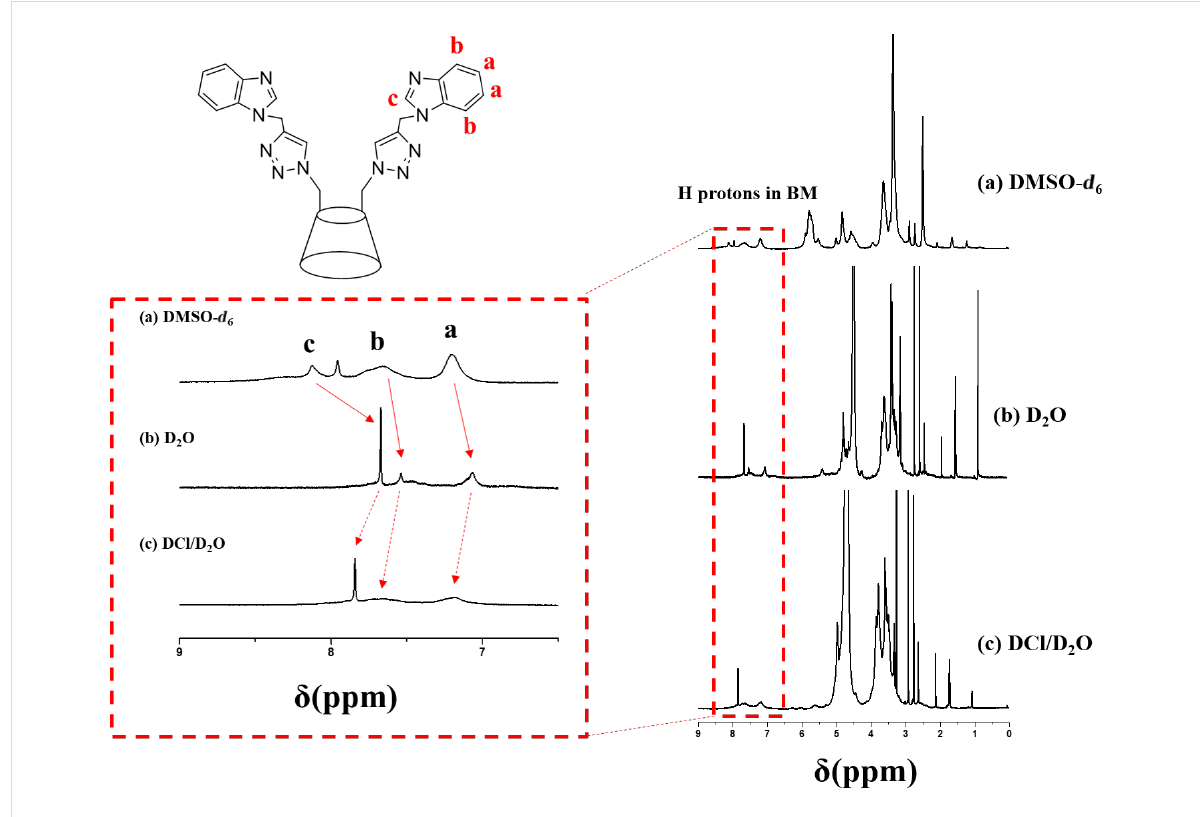
Figure 2: 1 H NMR spectra of β -CD-BM 2 -based supramolecular self-assemblies in DMSO- d 6 (a), D 2 O (b) and DCl/D 2 O (c), respectively.